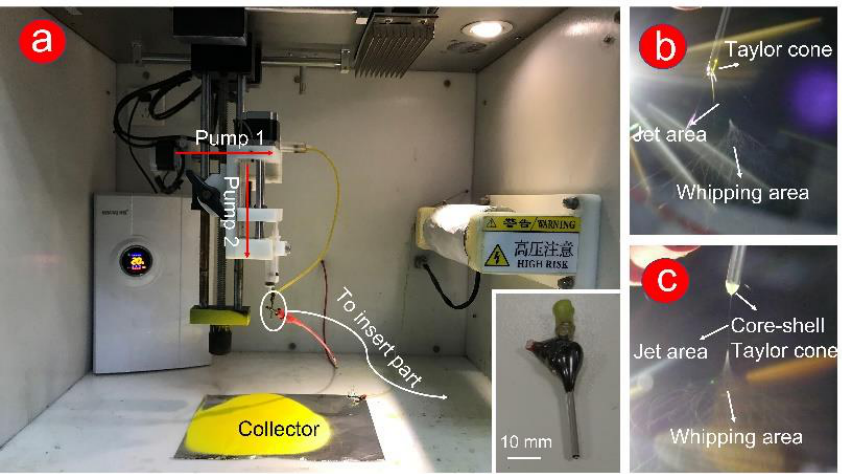
Figure 1. Digital photos of the coaxial electrospinning process. ( a ) Instrument and environment for the preparation of coaxial electrospun F2 fibers, including humidity and temperature control system, pumps, silicone tube, collector, and spinneret. The insert picture shows an enlarged clear picture of homemade spinneret; ( b ) the process of fabricating F1 fibers; ( c ) the process of fabricating F2 fibers. Two drug-loaded fibers (i.e., F1 and F2) were fabricated in this work. F1 was prepared using 7% ( w / v ) PVP with 2% ( w / v ) Cur at 0.9 mL · h − 1 , and 7 kV. F2 was prepared by